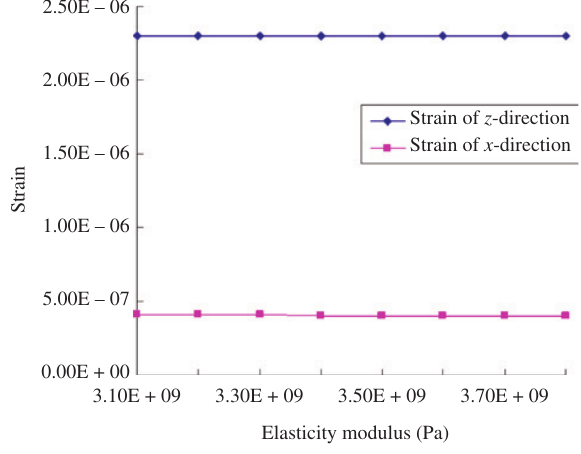
Figure 8: Relationship between polymer phase elastic modulus and strain of composite material ( U = 10